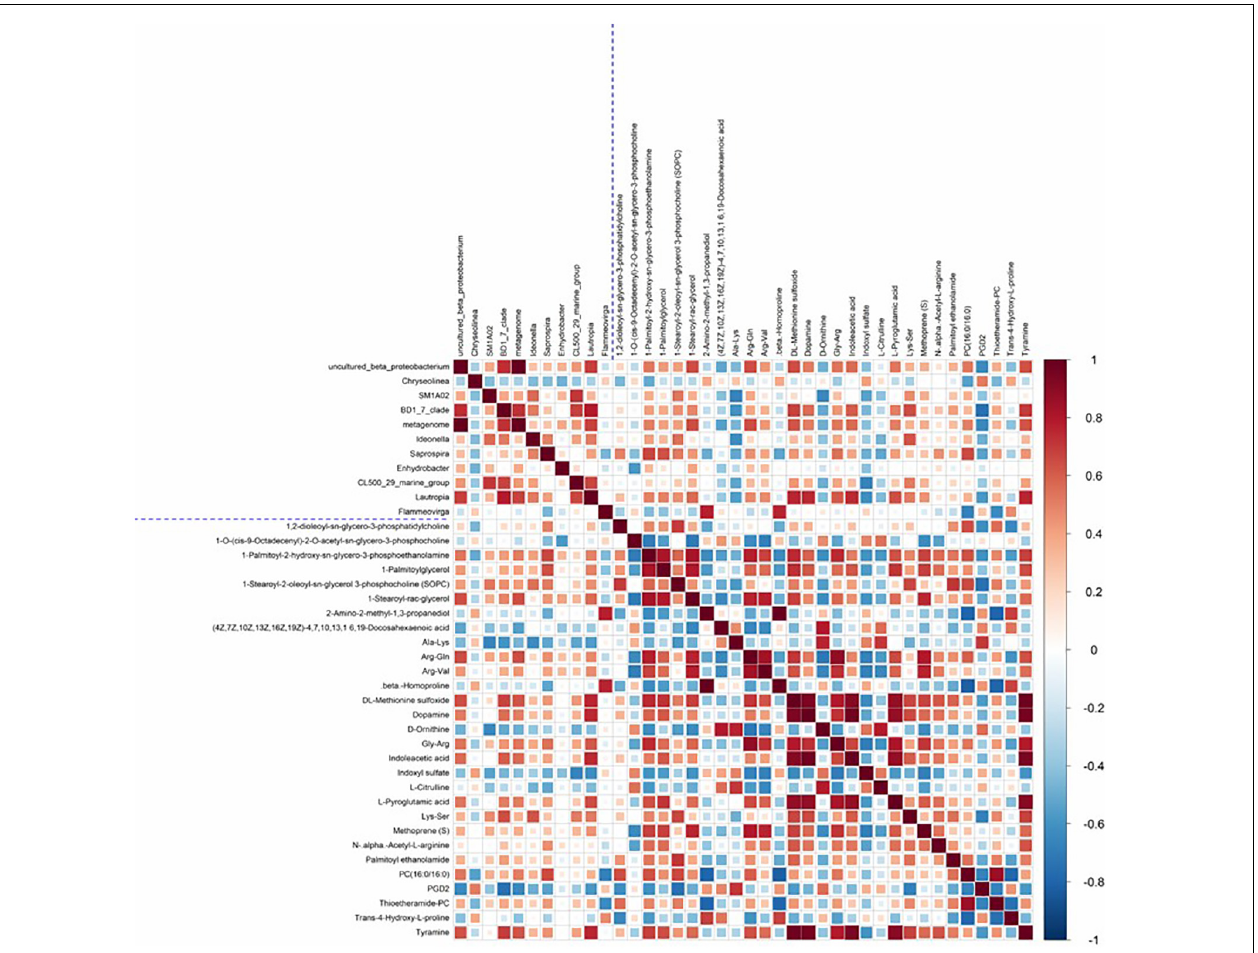
FIGURE 5 | Heat map of the Spearman correlation coefficient matrix for significantly different intestinal microbiota and significantly different metabolites. All intestinal microbiota and metabolites shown in Figure were significantly different between the two groups. The blue dashed line in the middle is the dividing line, and the correlation coefficient matrix heat map can be divided into four quadrants, with the upper left corner showing correlations between different intestinal microbiota, the lower right corner showing correlations between significantly different metabolites, and both the upper right and lower left corners showing correlations of significantly different intestinal microbiota and significantly different metabolites, with mirror